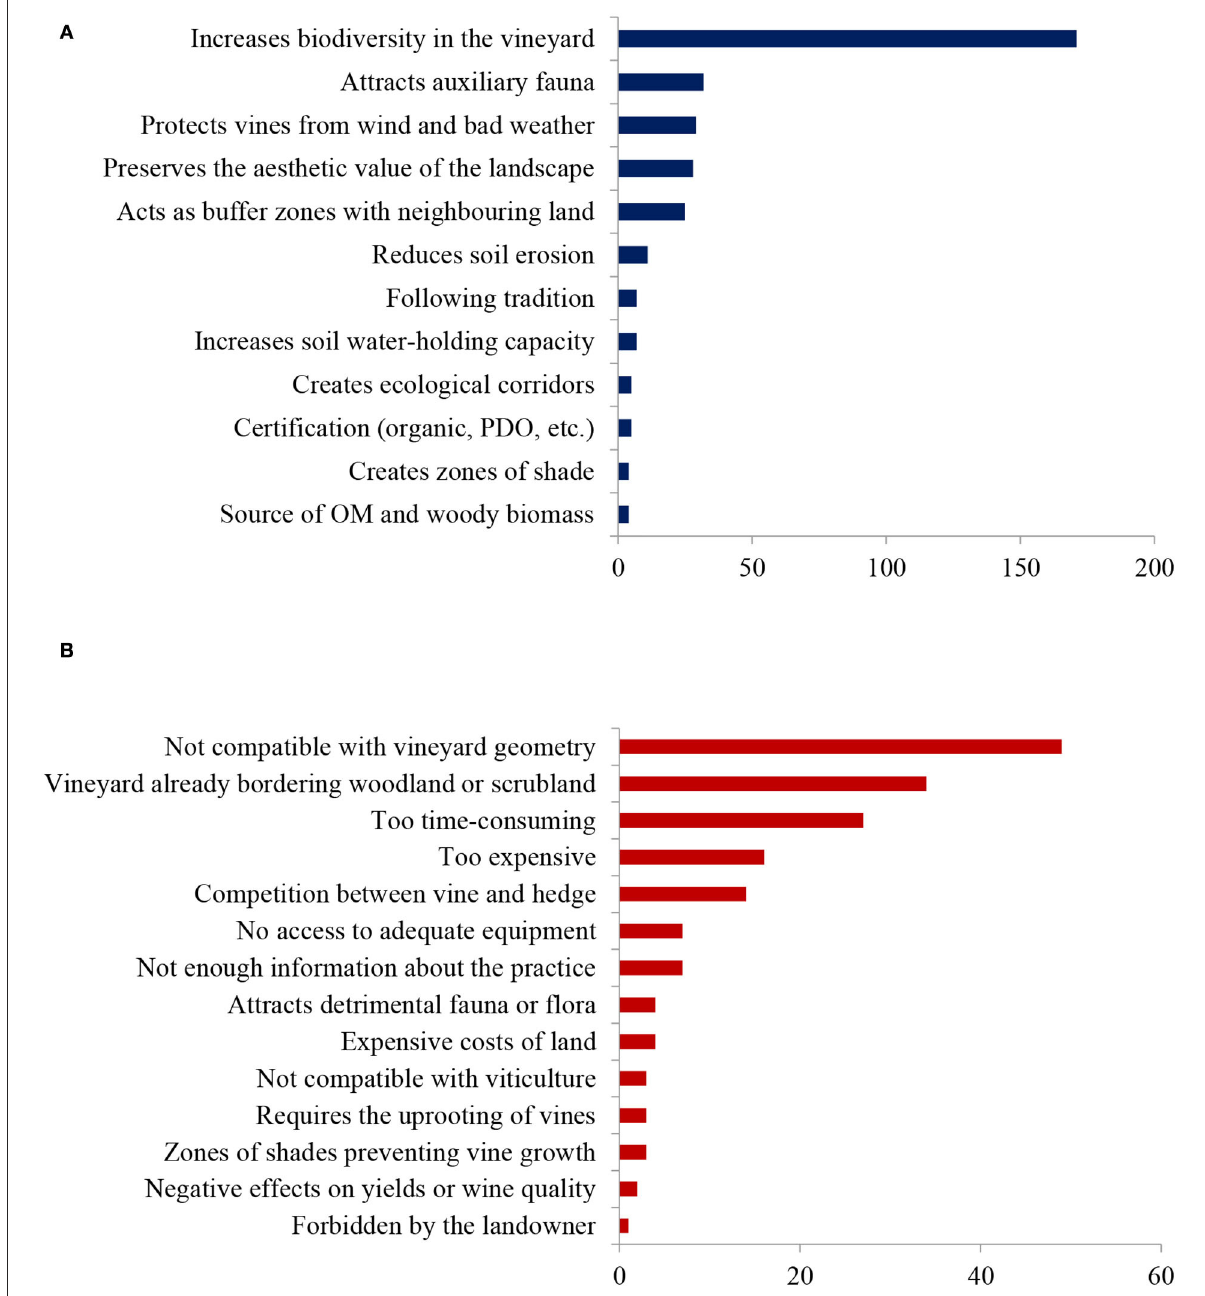
FIGURE6 Motives (A) and barriers (B) to the adoption of hedges in viticulture in France ( n = 220 and 136, respectively). Several responses were possible for each respondent. PDO, protected designation of origin; OM, organic matter.